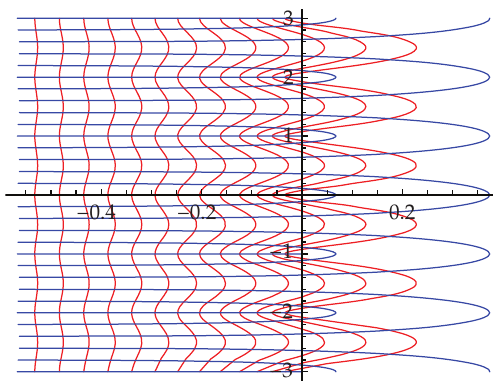
(cid:10) z tan πx dx. 0